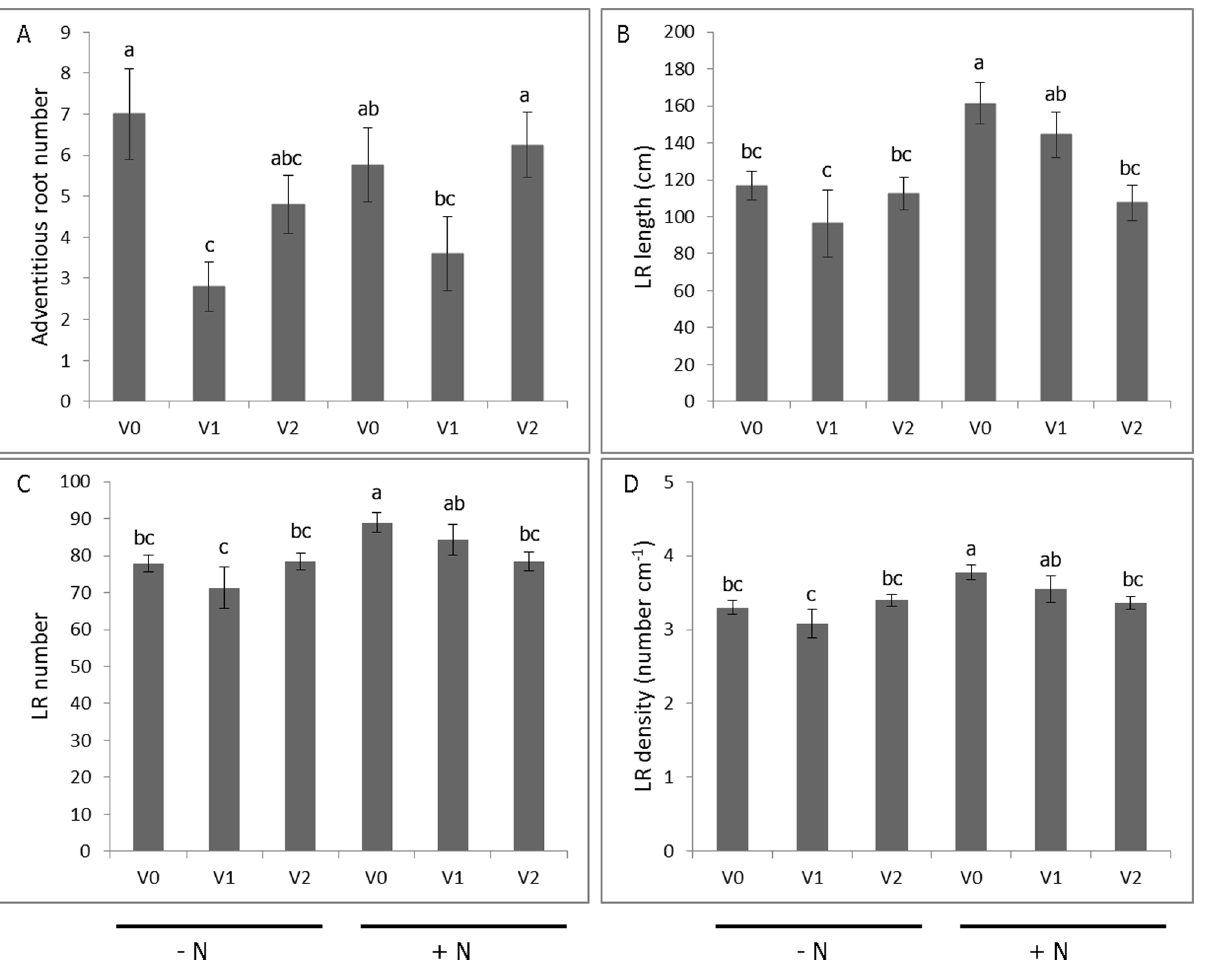
Figure 4. Variation in adventitious root number (A), first order lateral root length (B), first order lateral root number (C), and lateral root density (D) in response to virus and nitrogen treatments at the onset of storage root initiation in ‘Beauregard’ sweetpotato. + N = nitrogen provided as KNO 3 , - N=no nitrogen provided. V0 = plants derived from non-inoculated, virus-tested plant stock; V1 = plants derived from V0 plant stock graft inoculated with the potyvirus complex (SPFMV, SPVG, SPVC, and SPV2); V2 = plants derived from plant stock infected with SPCSV. Root length and number were transformed using log 10 and square root transformation, respectively, and Fisher’s LSD test at the 0.05 probability level was used to test for statistical significance. The data are expressed as means 6 SE from non-transformed